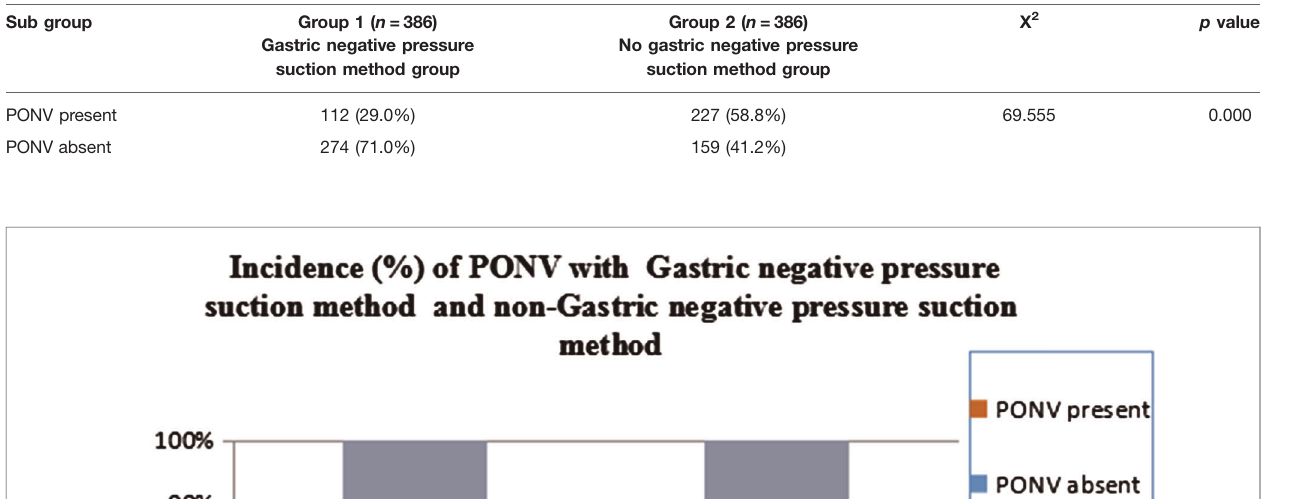
TABLE 2 | PONV results for the Gastric negative pressure suction method and no g Gastric negative pressure suction